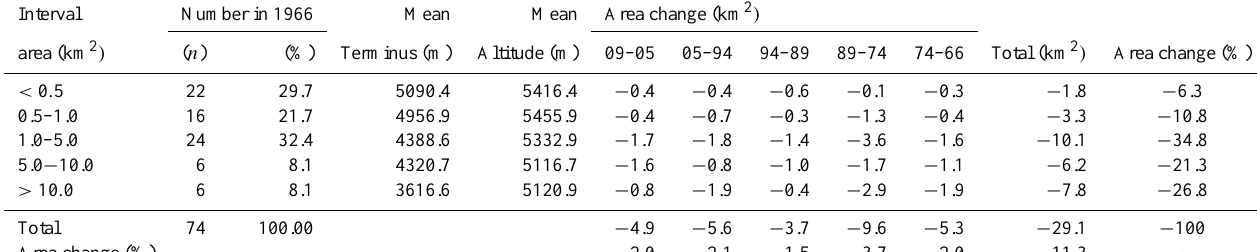
Fig. 3. Distribution of glaciers in 2009. (a) Distribution of glaciers in different area classes. (b) Distribution of glaciers by median altitude. (c) Distribution of glaciers by aspect. (d) Distribution of glaciers by mean slope.